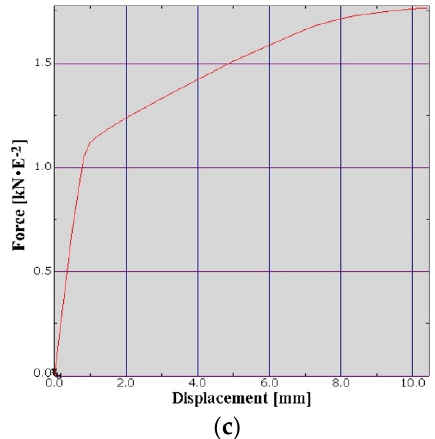
Figure 6. Compression plastic strain ( a ); strain components at integration point ( b ); graph of force– displacement to CBWC1 ( c ).